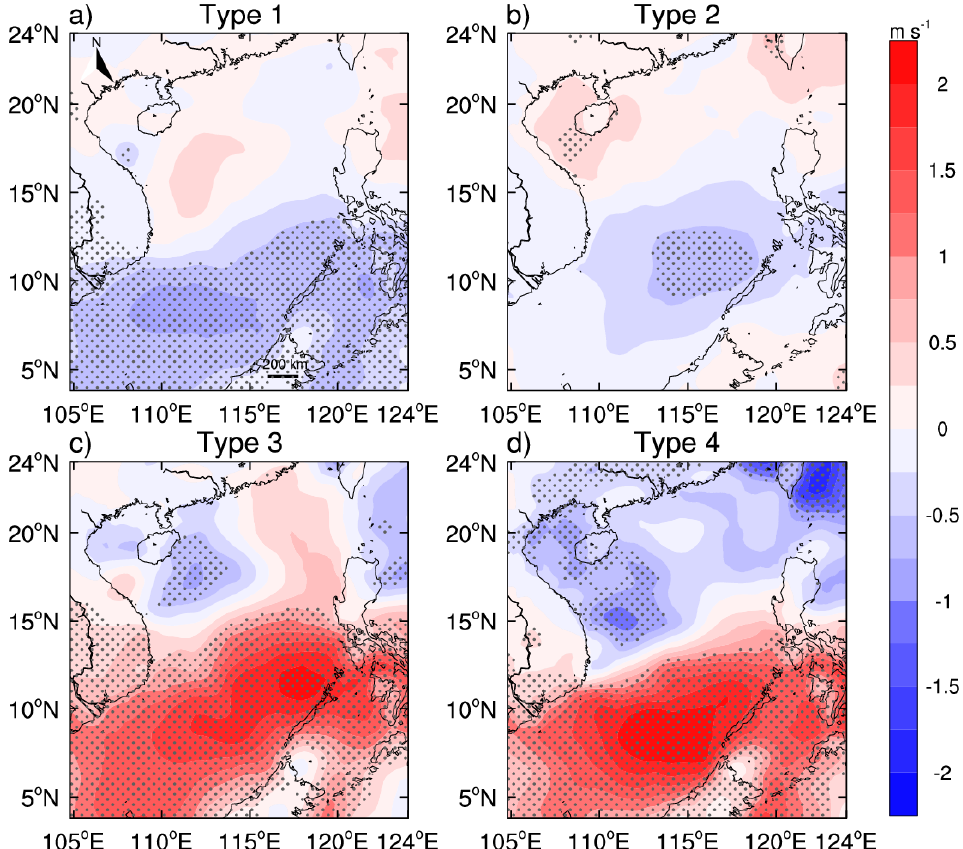
Figure 7. Wind speed anomaly at 10 m (shaded, m s −1 ) under the four synoptic types (the gray dots cover areas with significant differences): ( a ) Type 1; ( b ) Type 2; ( c ) Type 3; ( d ) Type 4. Sunlight also affects the SST and chl-a concentration. PAR anomalies show that large